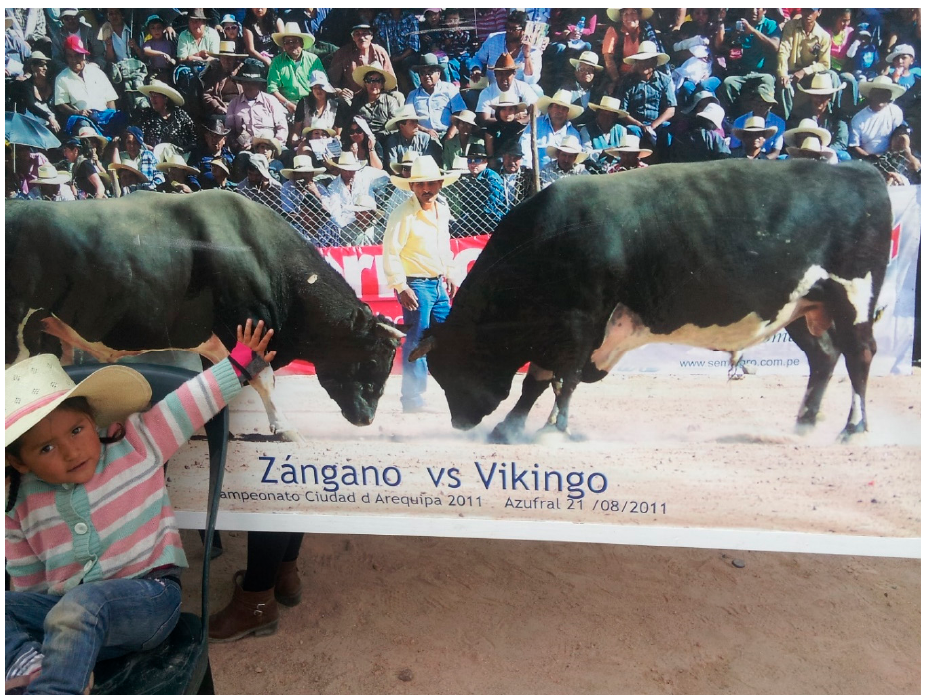
Figure 5. The street directly in front of the Mormon temple’s construction entrance. May 2018.